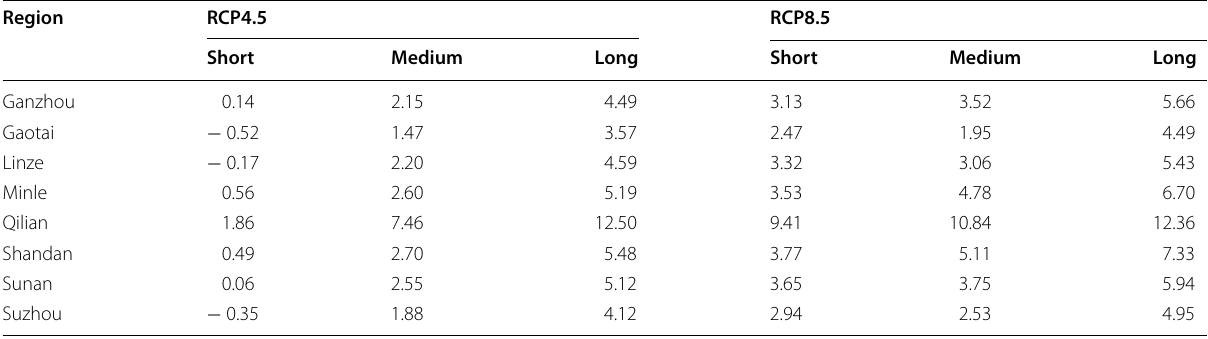
Table 3 Change in precipitation in June in three different periods in the future relative to the historical baseline period (1980–2004) in each county in the Heihe River basin